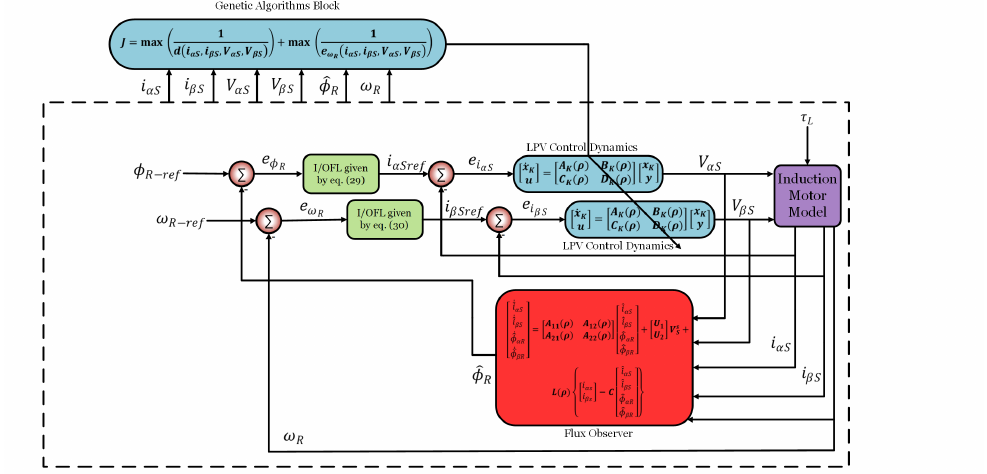
Figure 1. Optimized energy control